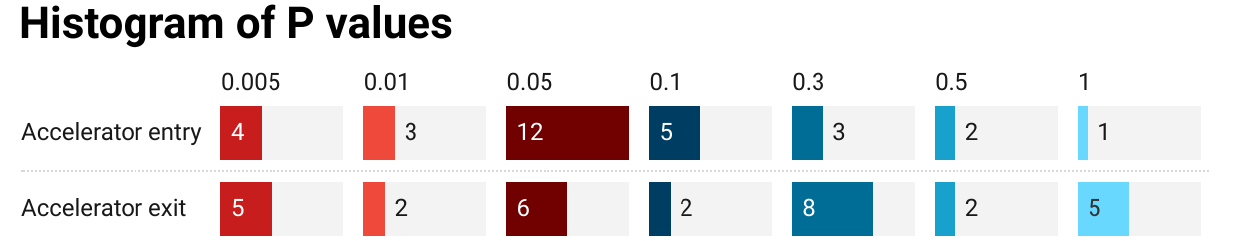
Figure 4. Histograms of Mann–Whitney test results comparing for equality of the 30 indicators of the COVID and pre-COVID cohorts at programme entry and exit.